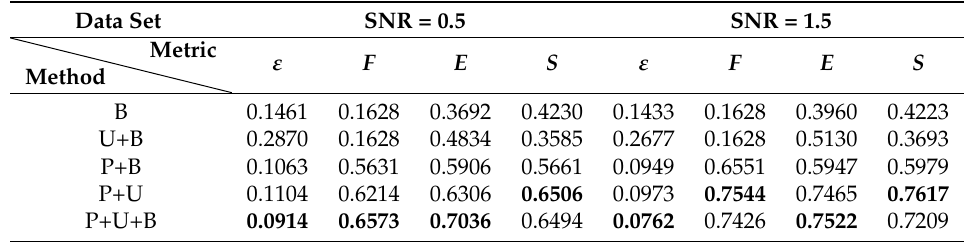
Table 2. Quantitative comparisons between different combination of modules from our PUB-SalNet model. B stands for a single unsupervised backpropagation module; U+B stands for U-SalNet architecture with B ; P+B means B based on the pre-training method; P+U means U-SalNet based on the pre-training method, note that this is actually not an unsupervised method; P+U+B is our proposed PUB-SalNet.